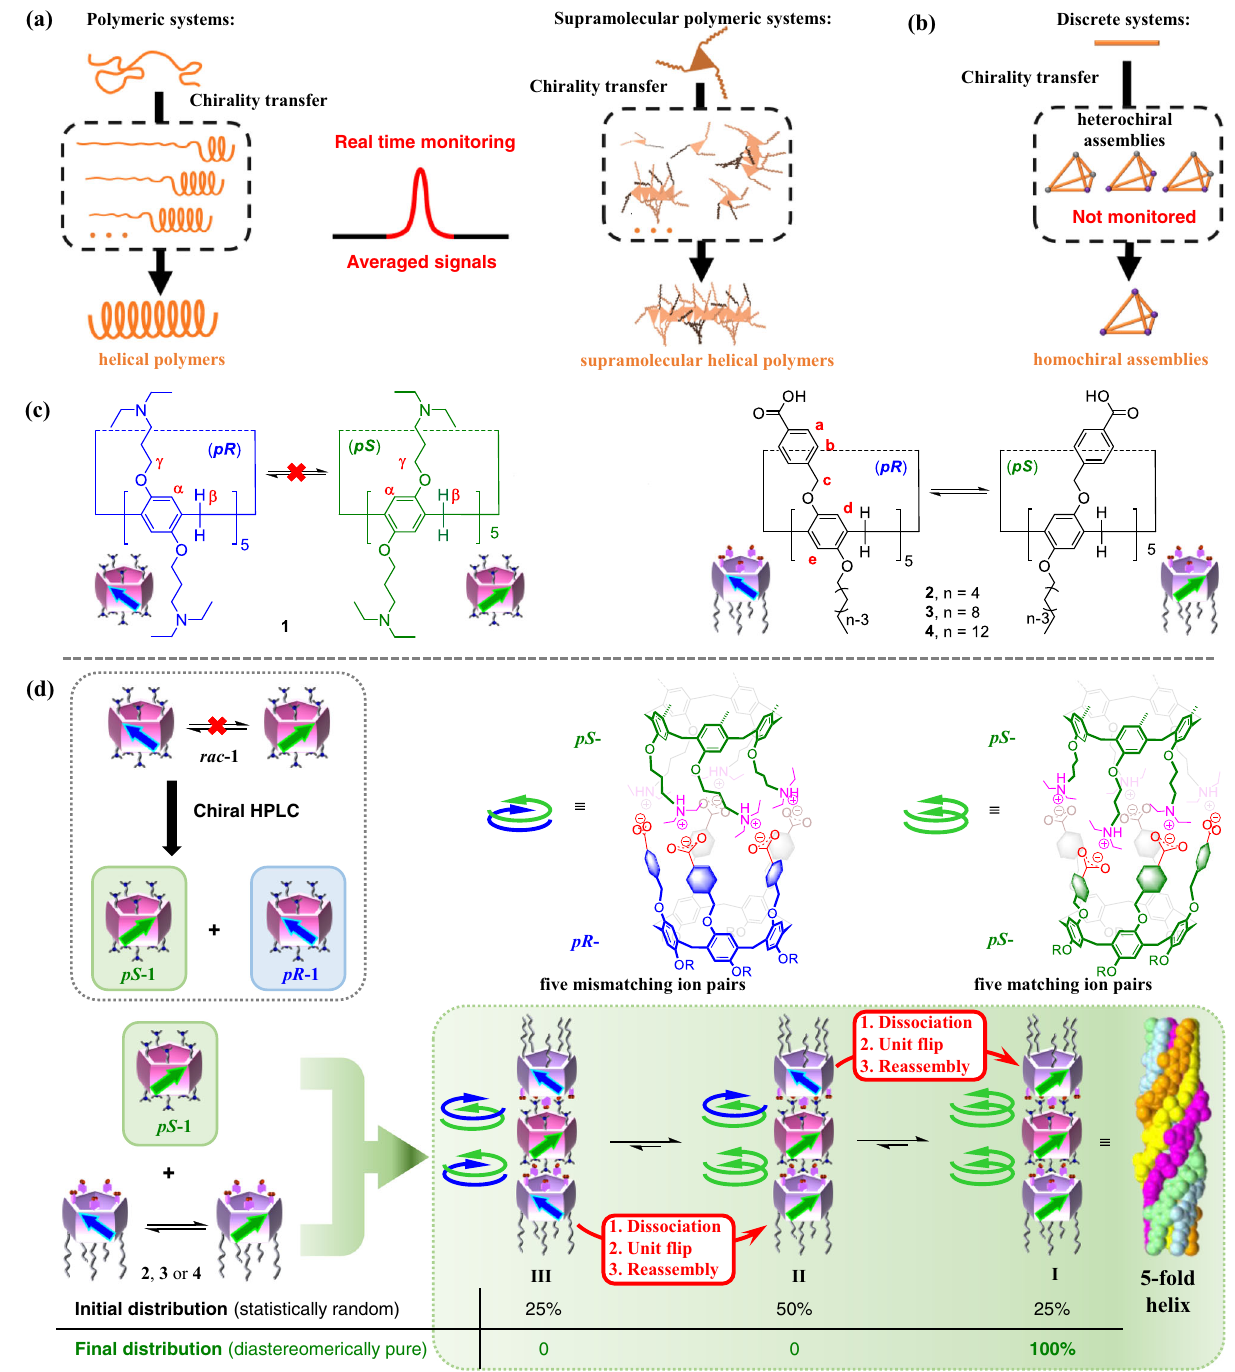
Fig. 1 | Real-time monitoring ofreported chiralitytransfer systems and that in the present study. a Real-time monitoring of chirality transfer in polymeric and supramolecularpolymeric systems, whichtypically re fl ect the averaged properties of each intermediate assembly in the system. b Discrete chirality transfer systems,